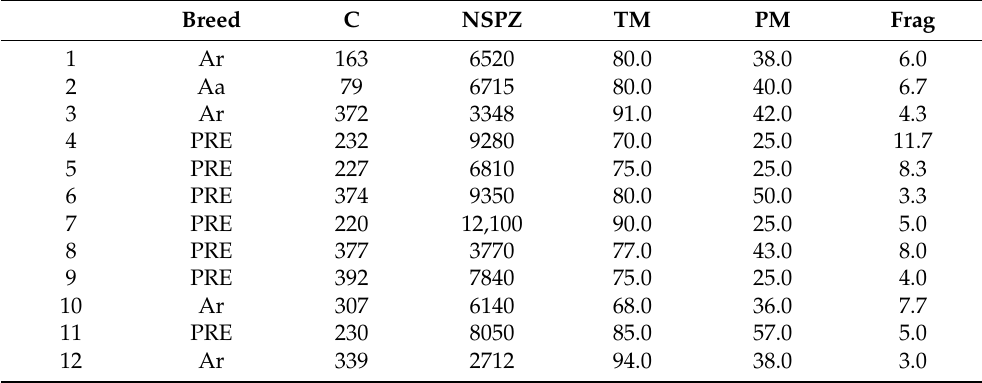
Table 1. Sperm quality analysis: Numbers represent animals. PRE: Andalusian. Aa: Anglo-Arabian. Ar: Arabian. C: sperm concentration (millions of cells/mL). NSPZ: total number of sperm (millions). TM: total sperm motility (%). PM: progressive sperm motility (%). Frag: sperm DNA fragmentation